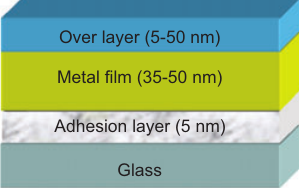
Figure 1 Schematic illustration of SPR lamellar structure of dielec- tric-on-gold